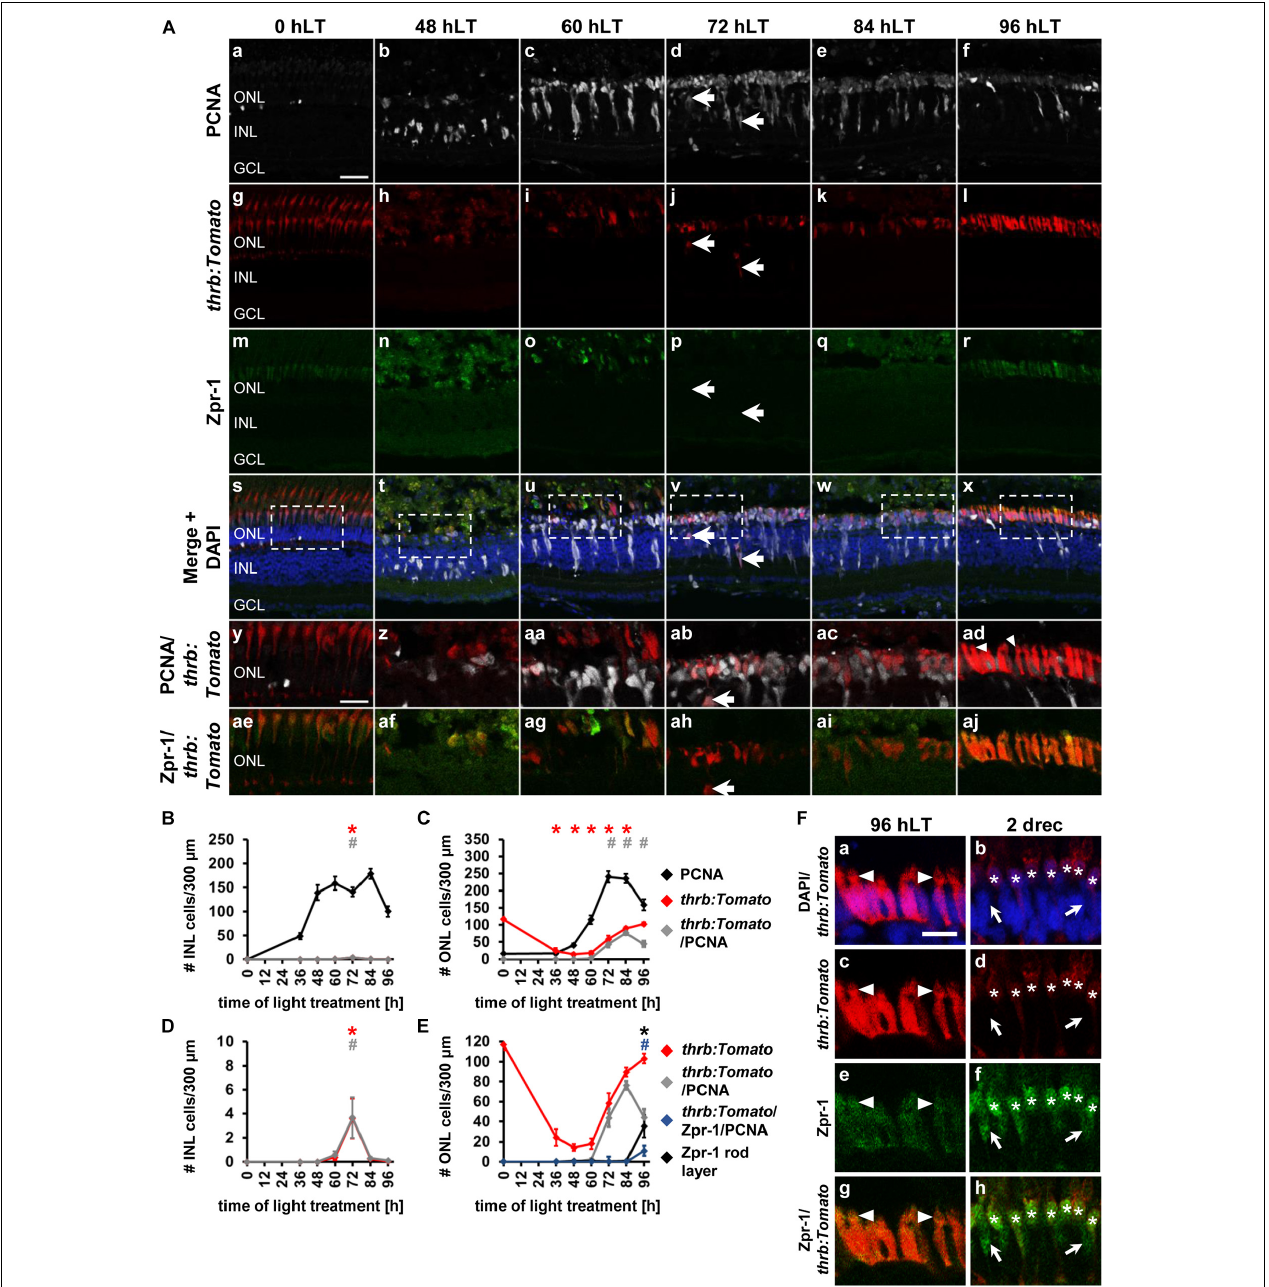
FIGURE 5 | Competence factor of red cone precursor cells, thrb , is upregulated in the light-damaged retina. (Aa–aj) Single z-plane confocal images of retinal sections from light-damaged Tg[thrb:Tomato]q22 zebrafish (Ag–l,As–aj) , (0, 48, 60, 72, 84, 96 hLT) immunolabeled for PCNA (Aa–f,As–ad) and the red/green double cone marker, Zpr-1 (Am–x,Aae–aj) and counterstained with DAPI (As–x) . (Ay–aj) Regions outlined in panels (As–x) at higher magnification. Arrows, thrb:Tomato -positive INL cells. Scale bars, 20 µ m (Aa) and 10 µ m (Ay) . (B,C) Number of PCNA-positive, thrb:Tomato -positive and PCNA and thrb:Tomato -double positive cells in the INL (B) and ONL (C) over the light treatment timecourse. (D) Number of thrb:Tomato -positive and thrb:Tomato and PCNA - double positive cells in the INL at a different scale to (B) . (E) Number of thrb:Tomato -positive, thrb:Tomato and PCNA-double positive cells in comparison to Zpr-1-positive cells and thrb:Tomato , PCNA and Zpr-1-triple positive cells in the ONL of retinas exposed to constant intense light for 0, 36, 48, 60, 72, 84 and 96 h. Mean ± SE, n ≥ 9, ∗ p Tukey < 0.05 and # p < 0.05 indicate comparisons to 0 hLT for the different measures that were assessed. The symbols are color-coded according to the line that they represent in the corresponding graphs ( p ANOVA , see Table 1 ). Note, significance was not determined for PCNA in panels (B,C) and symbols indicating significance for thrb:Tomato -positive and thrb:Tomato and PCNA-double-positive cells are not shown in panel (E) , as they are indicated in panel (C) . (F) Single z-plane confocal images of retinal sections from Tg[thrb:Tomato]q22 zebrafish (Fa–d,g,h) co-labeled with Zpr-1 (Fe–h) and DAPI (Fa,b) at 96 hLT [cells indicated by arrowhead in panel (Aad) at higher zoom] and 2 drec. Arrowheads illustrate the presence of small inner/outer segments. Astericks, thrb:Tomato and Zpr-1 double positive cells. Arrows, Zpr-1-positive and thrb:Tomato -negative cells. Scale bar, 10 µ m.